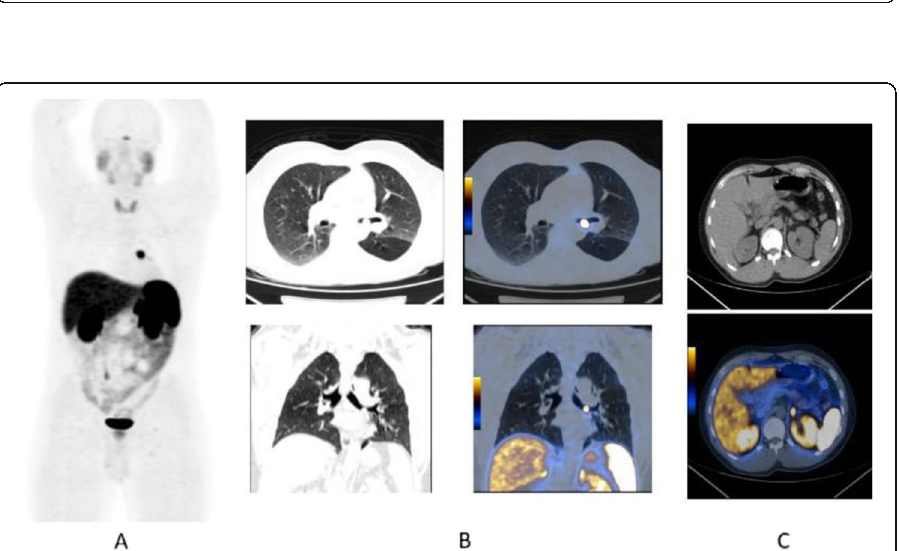
Fig. 51 68 Ga-DOTA peptide, staging of endobronchial carcinoid tumour, specificity. Clinical history : 33 y.o. man. Persistent cough and wheezing not responsive to bronchodilators. CT showed endobronchial node in left main bronchus. Bronchoscopy biopsy: NET. PET/CT findings : uptake in node protruding into the left main bronchus ( a MIP, b CT and fused images). Focal uptake in the left adrenal gland ( c ). MRI confirmed the presence of an adrenal